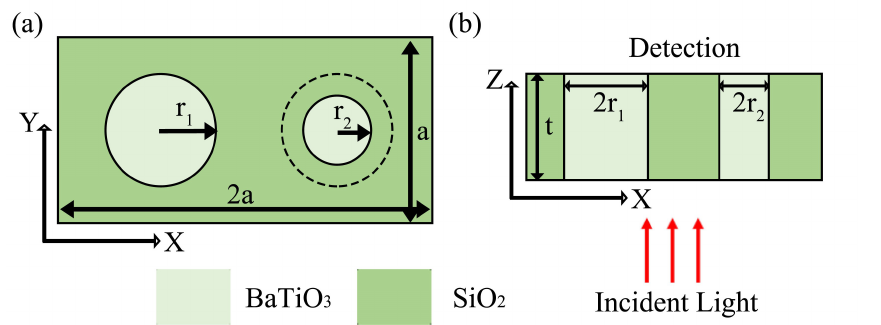
Figure 2. ( a ) 2D plane diagram of a BTO rectangle unit cell in XY plane. ( b ) 2D plane diagram of a BTO rectangle unit cell in XZ plane.